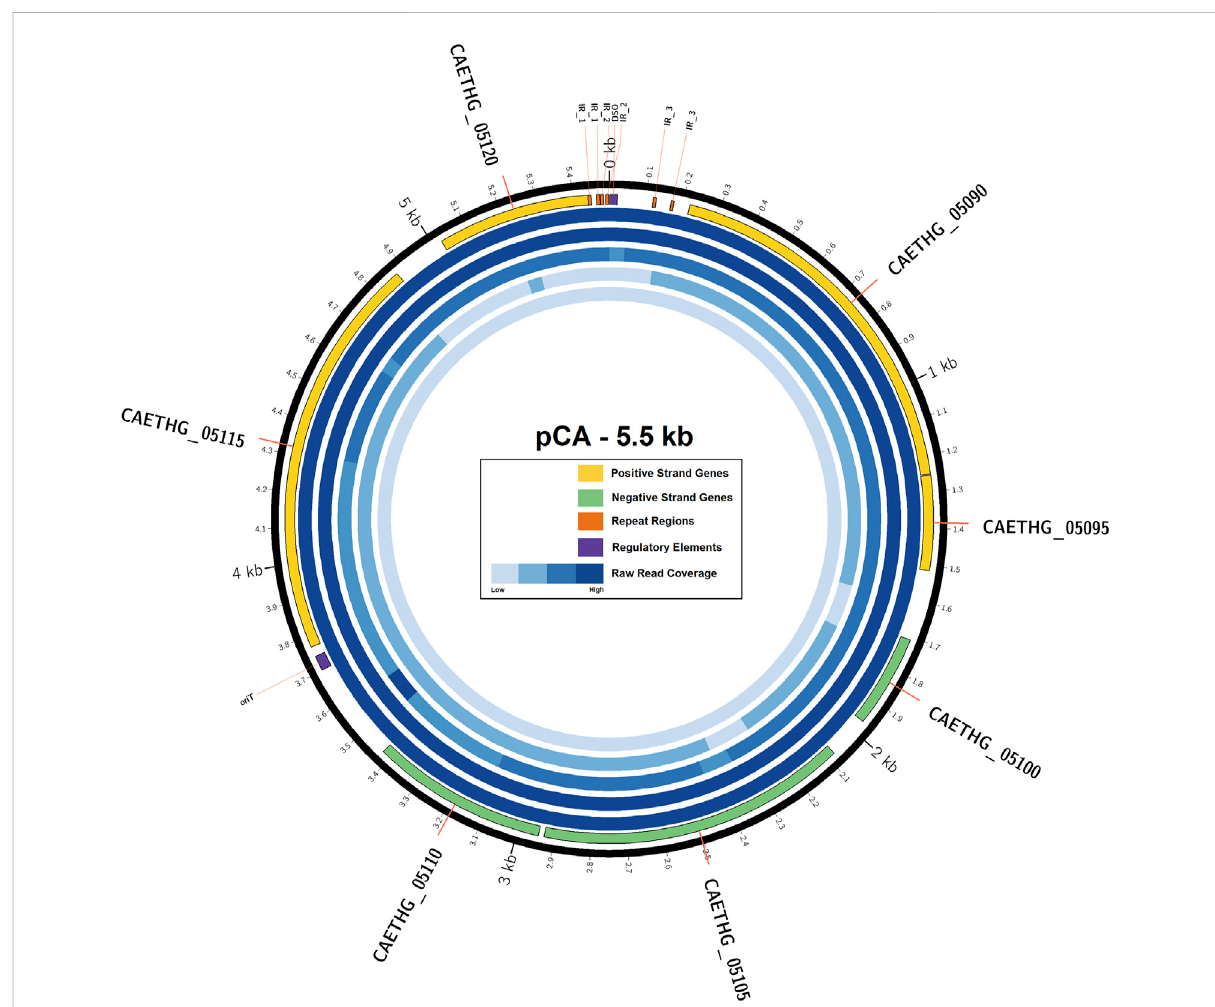
FIGURE 1 Plasmid pCA, its genes, and sequence coverage. The outermost ring (black) represents the circular pCA plasmid sequence (5.49 KB). The next inner ring represents the seven plasmid genes encoded on positive (yellow) and negative (green) strands, regulatory elements (purple), and repeat regions (orange). The next fi ve rings represent the raw-read coverage from Illumina, 454, Ion Torrent and PacBio technology, respectively. Feature coordinates are also available in the GenBank